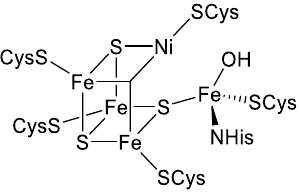
Figure 1. Active site of Ni-CODH [6].